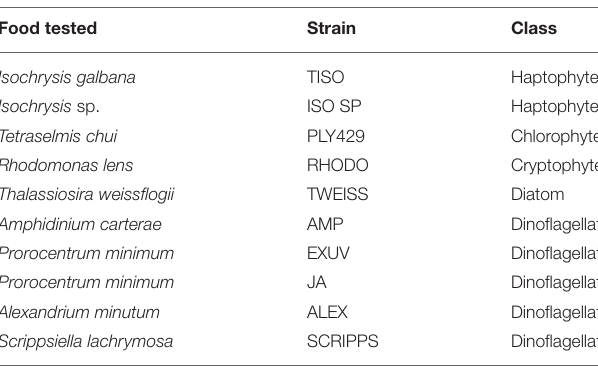
TABLE 1 | Microalgae tested as food for S. rassoulzadegani in light vs. dark experiments. Food